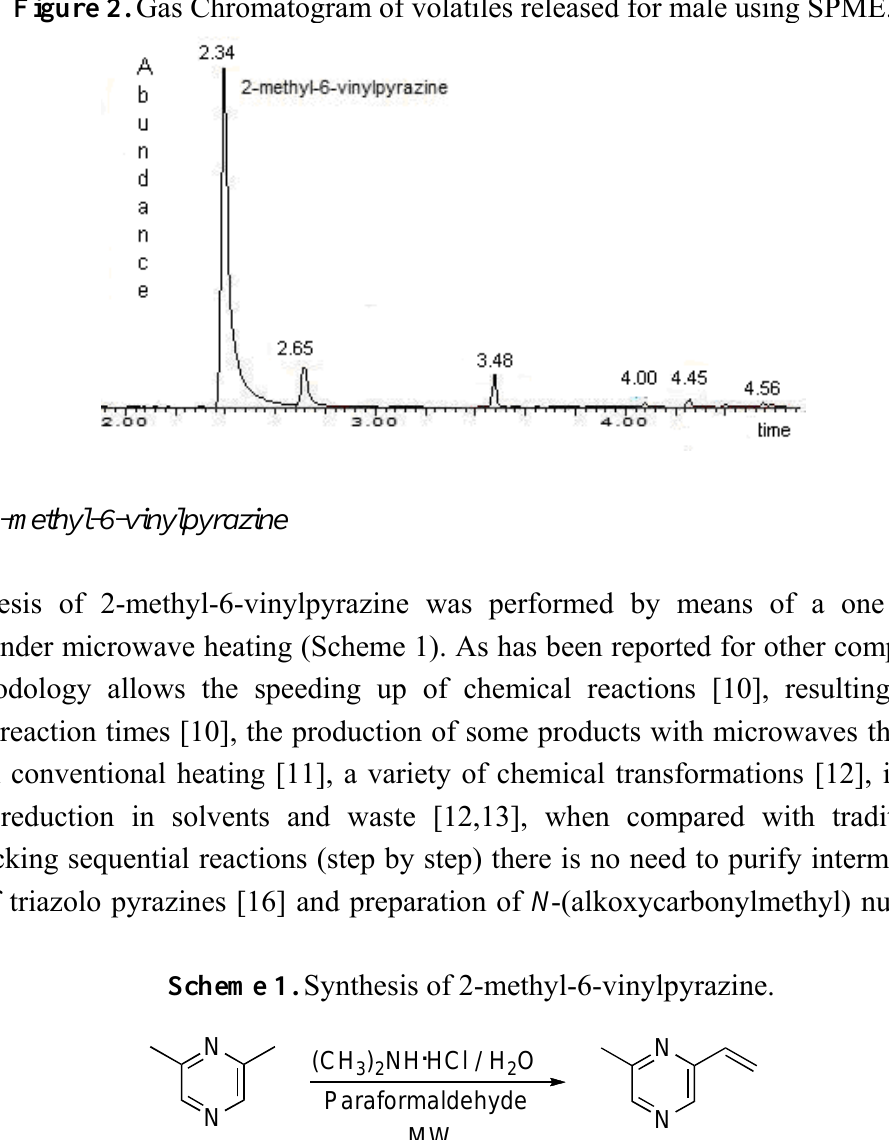
Figure 2. Gas Chromatogram of volatiles released for male using